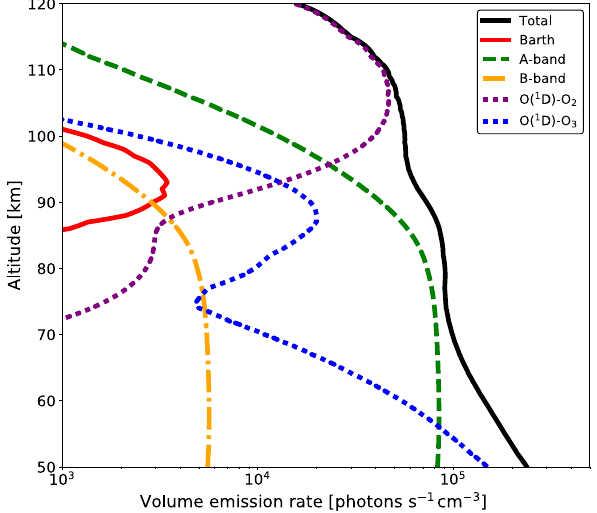
Figure 2. Modeled O 2 A-band dayglow emission profile at 30 ◦ N and 220 ◦ E for 14:40 local solar time simulated from the HAM- MONIA model. A band and B band (dashed green line and dot- dashed orange line, respectively) are the contributions from the res- onant absorption. O ( 1 D ) -O 2 and O ( 1 D ) -O 3 (dotted purple line and blue line, respectively) are the contributions from the collision with O ( 1 D ) . The solid red line is the contribution from the Barth process. The black curve denotes the total A-band